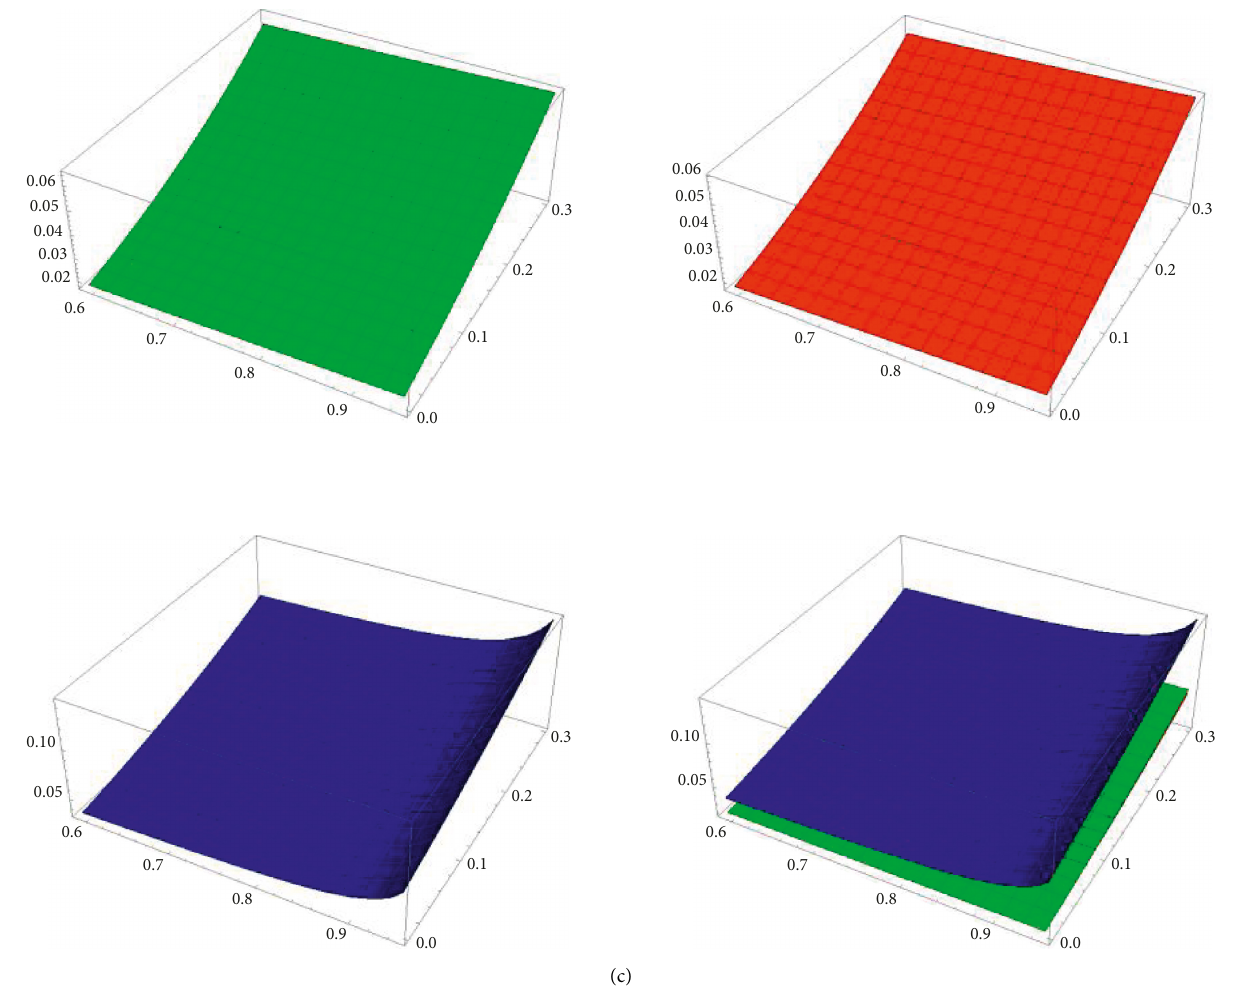
Figure 5: Comparison of O2O CLSC’s profits under wholesale price contract (green), revenue-sharing contract (red), and financial support contract (blue). (a) Comparison of retailer’s profits. (b) Comparison of manufacturer’s profits. (c) Comparison of whole channel’s